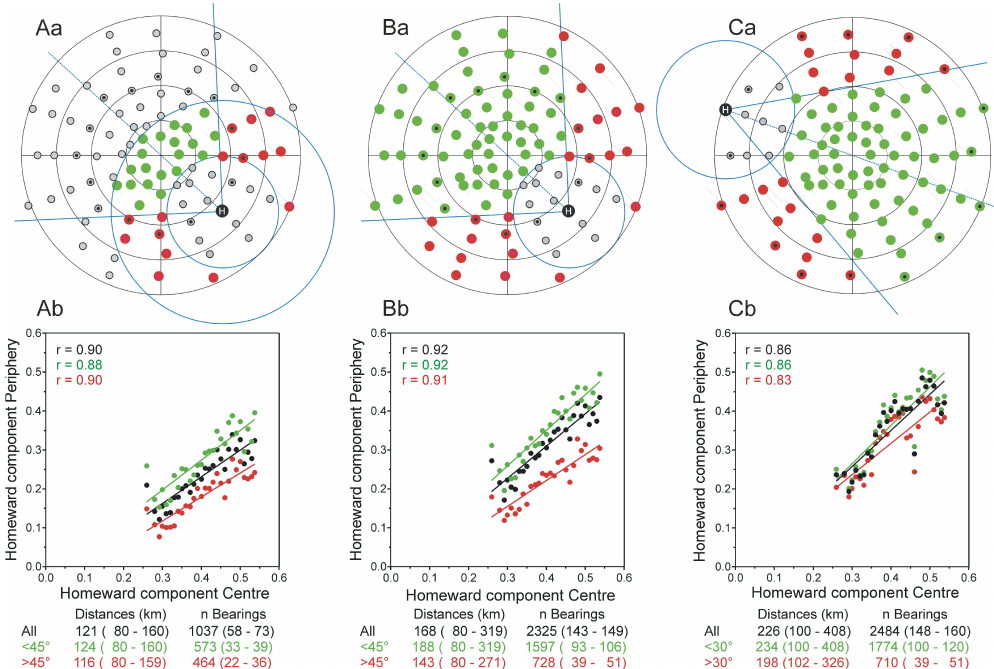
Fig. 7. Orientation towards peripheral goal sites. (Aa–Ca) (distance of circles from centre 50–200km): three modes of selection of sampling sites. A black dot labelled “H” indicates the current home site in the case of a particular example. Blue circles and lines divide the surrounding sites into sections according to distance and angle from H. Green are included sites within an angle of ± 45 ◦ or ± 30 ◦ , red are included sites outside of this sector. Grey sites are not included in the calculations. In addition to the sites labelled H, 15 more sites in each diagram at a similar distance, marked by a small black dot, were used as corresponding home sites with corresponding geometrical subdivisions around. (Ab–Cb) Correlations between 28 original centre-related c H values at regular steps from 0.26 to 0.54 (abscissa) and mean homeward components related to 16 peripheral home sites H, in each of the 28 cases (data points in the graph) using the same weighted VOC profile (ordinate). Below the graphs: means and ranges of distance between start and goal site and number of included VP bearings (in total and range per home